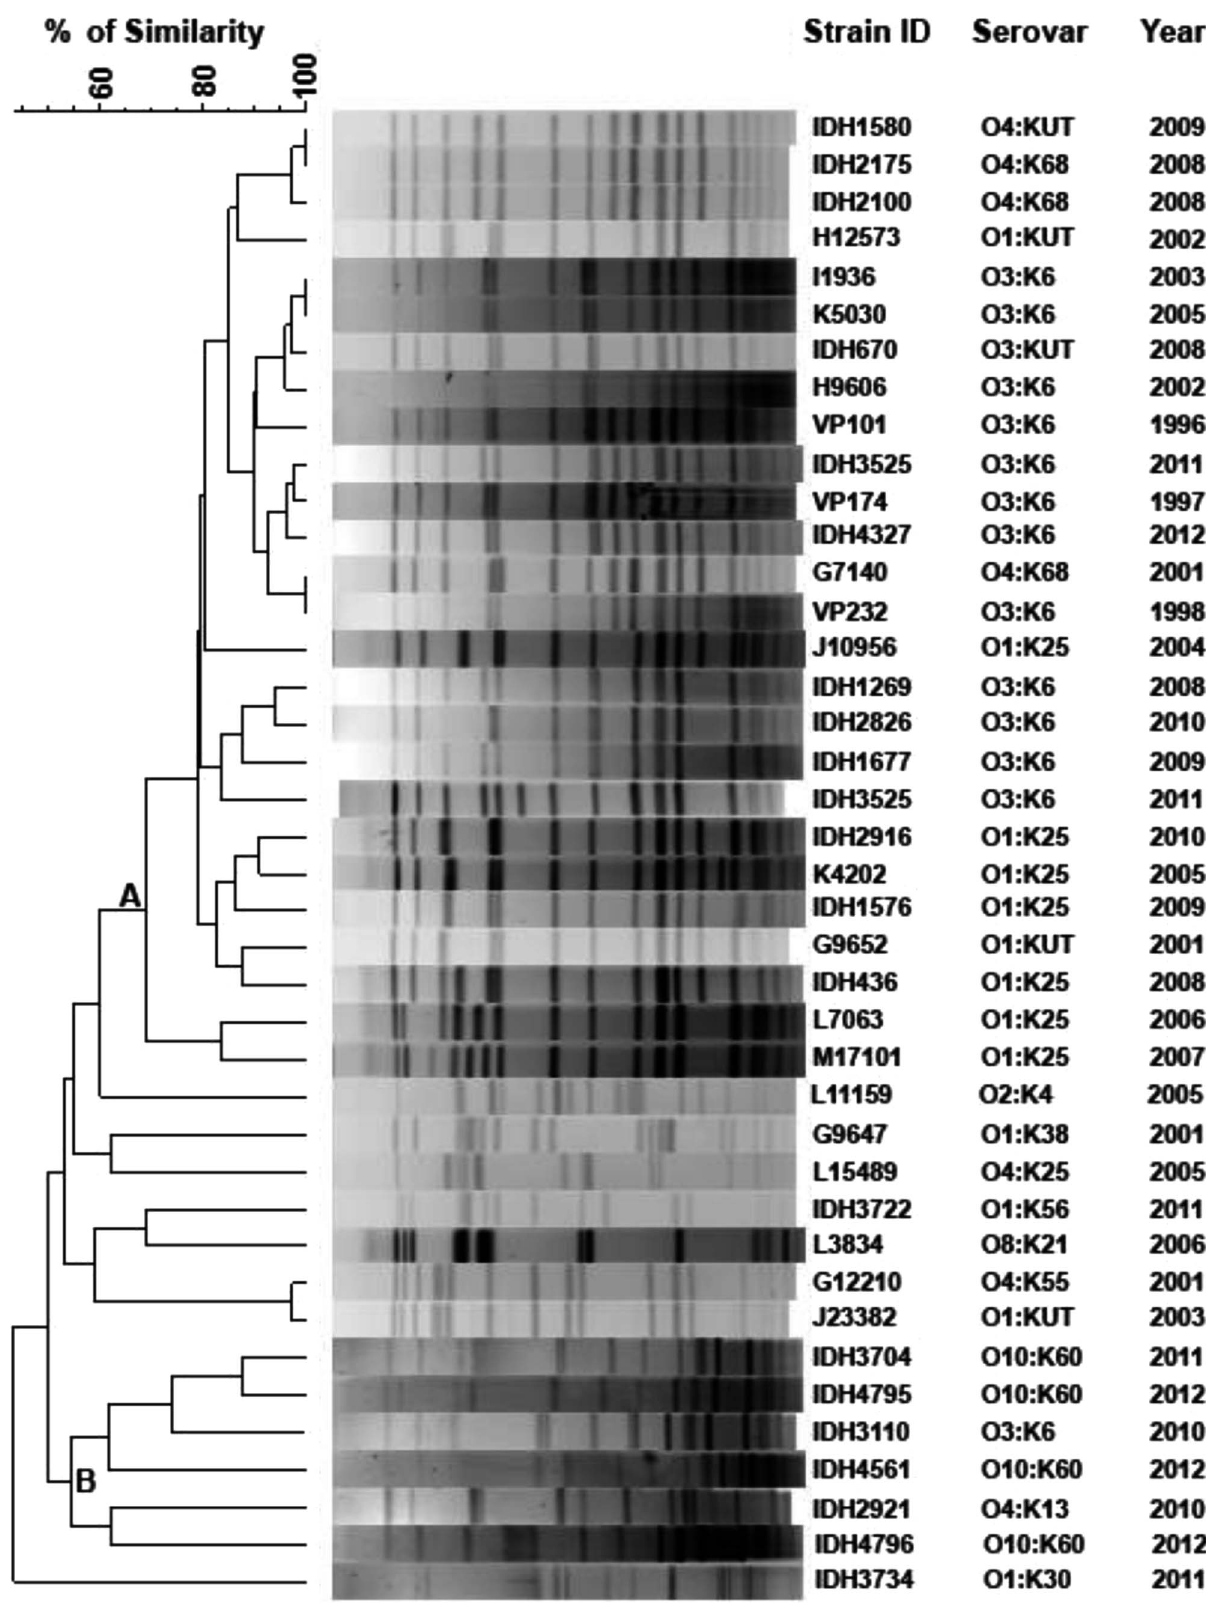
Figure 2. Not1 digested PFGE profile of V.parahaemolyticus with dendrogram. Clustering was performed using the unweighted pair group method (UPGMA) and the Dice correlation coefficient with a position tolerance of 1.0%. doi:10.1371/journal.pntd.0002815.g002 PLOS Neglected Tropical Diseases |